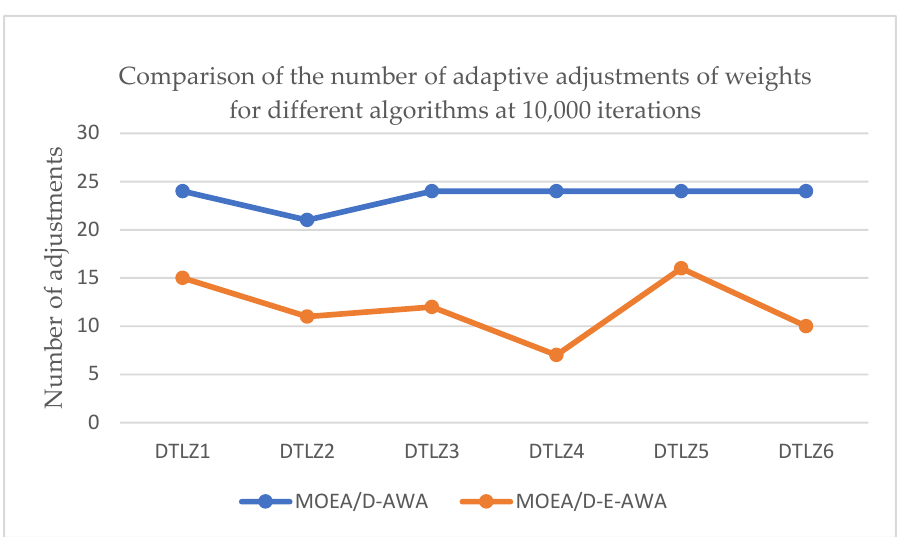
( b ) Figure 1. Comparison of MOEA/D-AWA and M-E-AWA on complex datasets. (( a ) Comparison of MOEA/D-AWA and M-E-AWA on IOMP1. ( b ) Comparison of MOEA/D-AWA and M-E-AWA on IMOP2). 4.2.3. Comparison of the Number of Adjustments under Different Iterations The experiments in this section mainly serve to verify the superiority of the im- proved algorithm M-E-AWA over the original algorithm in terms of the number of itera- tions required to change the weights adaptively for increasing numbers of iterations. As